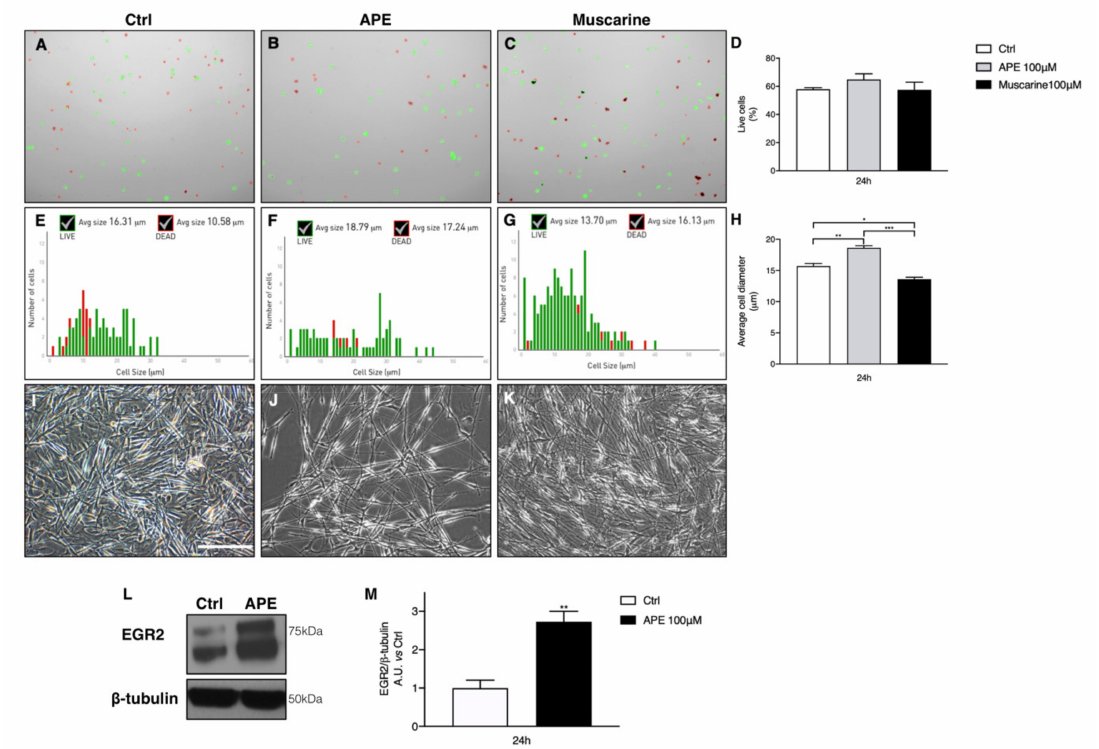
Figure 3. Analysis of cell death after trypan blue assay, using Cell Countess. ( A – D ) The analysis showed that both cholinergic agonists are not toxic for hSCs (( A – C ), green dots are live cells, whereas red dots are dead cells). In ( D ), the percentage of the live cells under di ff erent experimental conditions is reported. ( E – G ) Countess analysis shows a significant increase of average cell diameter. The graphs show the analysis of cell diameter, where the green columns and the red columns represent the live cells or dead cells, respectively, presenting a specific diameter. Up the panels, the analyses show the average cell diameter for live and dead cells (( E ) control; ( F ) APE; ( G ) muscarine)). In ( H ), the average of cell diameter is reported; APE induces an increase of cell diameter after 24 h of treatment (** p < 0.01 APE vs. ctrl; APE = 18.63 ± 0.33 µ m; *** p < 0.01 APE vs. Muscarine), whereas muscarine exposure induces a reduction in average cell diameter (* p < 0.05 muscarine vs. ctrl; muscarine: 13.60 ± 0.32 µ m). ( I – K ) Images in phase contrast showing hSC morphology and density after APE and muscarine treatments (scale bar: 100 µ m); (( I ) control; ( J ) APE; ( K ) muscarine)). ( L , M ) The analysis of Egr2 protein expression, by Western blot analysis, has shown that APE induces a significant upregulation of Egr2 protein expression (** p < 0.01, APE treatment vs. ctrl = 2.73 ± 0.27). β -tubulin was used as protein reference. Data are represented as mean ± SEM of three independent experiments performed in three di ff erent